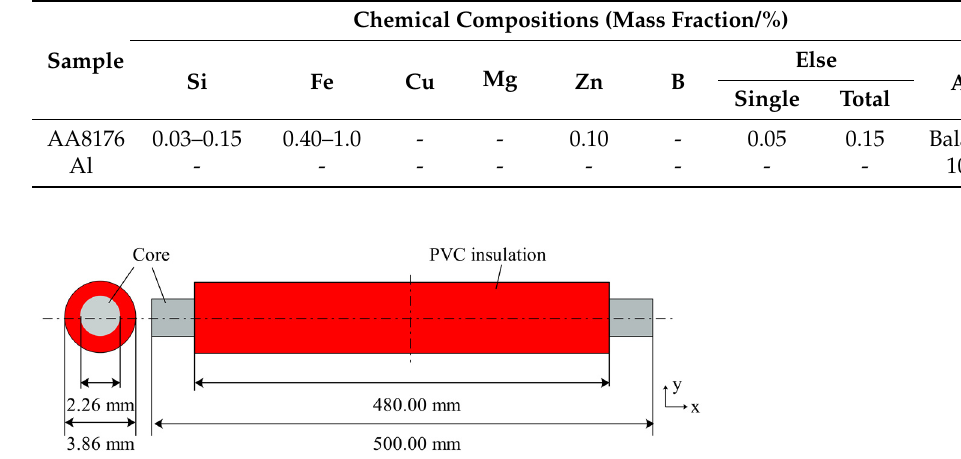
Figure 1. Schematic of the experimental apparatus. Table 1. Chemical compositions of wires (mass fraction/%).